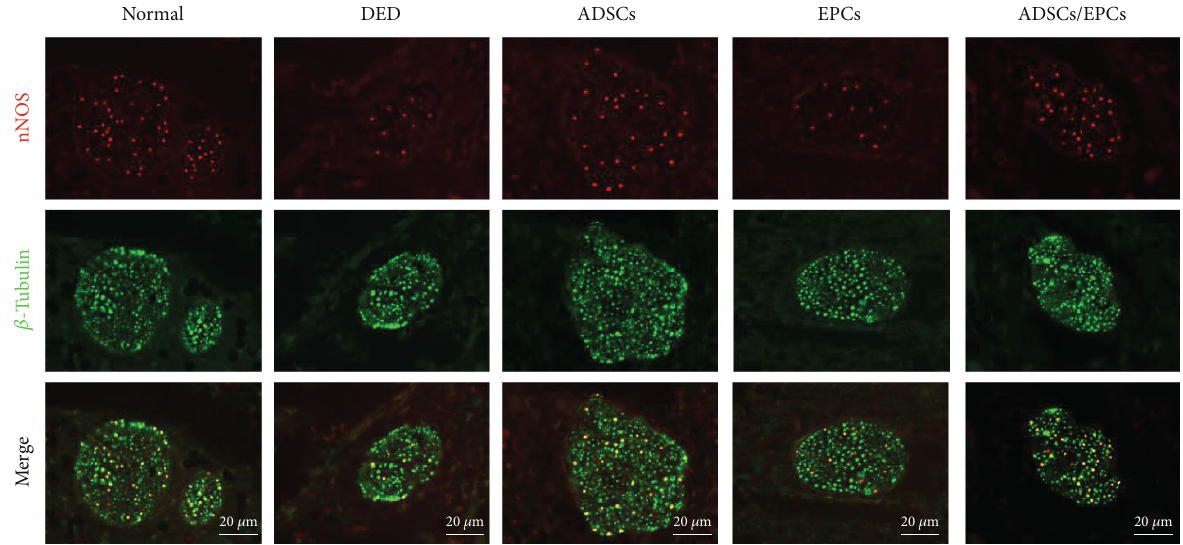
Figure 6: Transplantation of ADSCs or ADSCs/EPCs increased the nNOS-positive fi bers in the penile dorsal nerve. Representative images of fl uorescence costaining of nNOS (red) and β -tubulin (green) in the penile dorsal nerve. Scale bar: 20 μ m. nNOS: neuronal nitric oxide